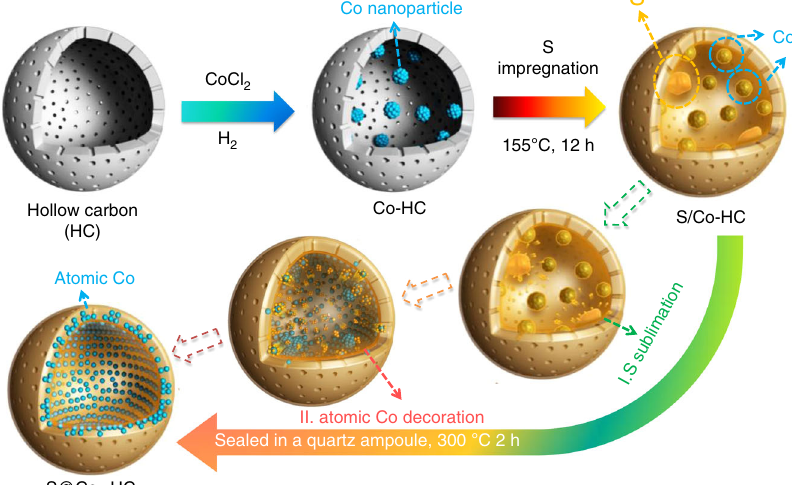
Fig. 1 Schematic illustration of synthesis. Schematic illustration of the synthesis of the hollow carbon decorated with cobalt nanoparticles (Co-HC). After sulfur (S) impregnation, the S/Co-HC is heat treated to generate atomic Co-decorated hollow carbon as a sulfur host material (S@Co n